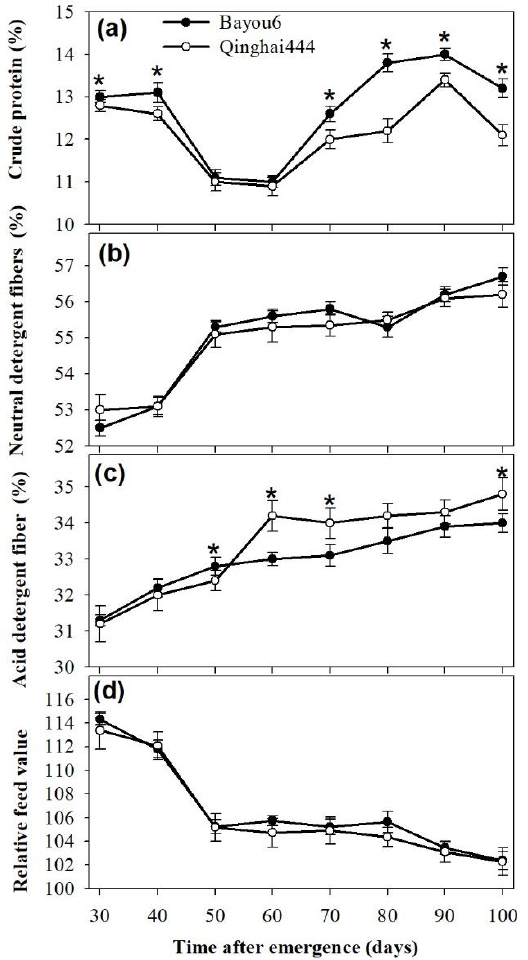
Figure 2. The crude protein ( a ), neutral detergent fiber ( b ), acidic detergent fiber ( c ), and relative feed value ( d ) in aboveground biomass of oat in the growing process. Data are means ± SE ( n = 4). * indicates a significant difference ( p < 0.05) between the two oat species (Bayou6 and Qinghai444) under the same growing stage.